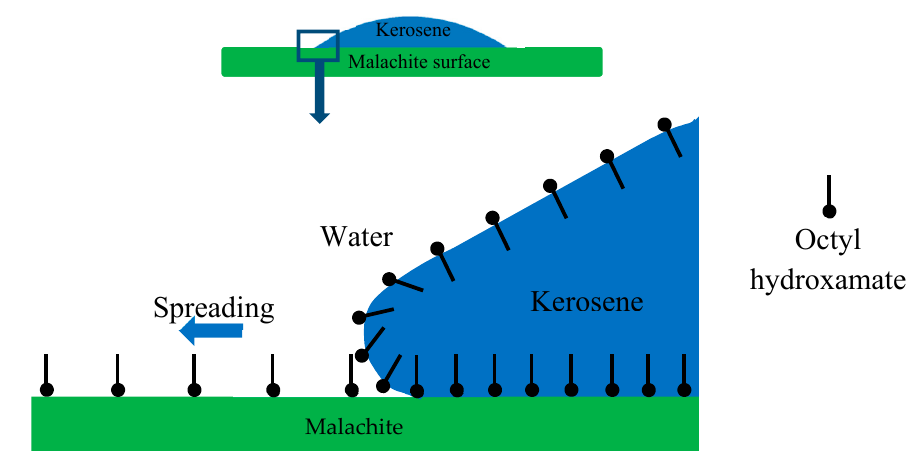
Figure 11. Schematic representation of enhancement of kerosene spreading on malachite surface by using octyl hydroxamate as an emulsifier.